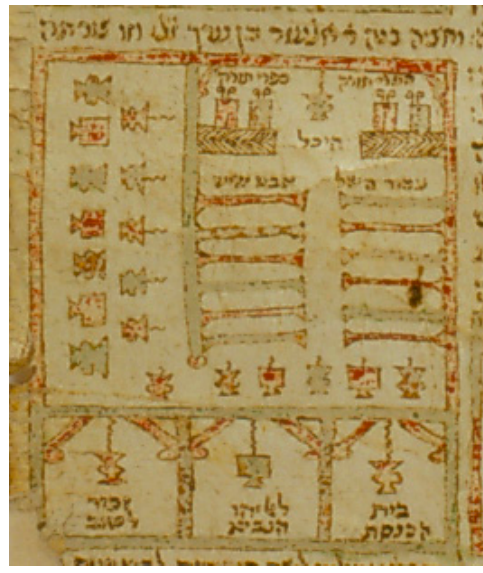
Figure 9. Jerusalem, National Library, The Synagogue of Elijah in Jobar, first half of the 16th century, Ms. Heb. 38.1187, used with permission from the National Library of Israel collection, (detail).